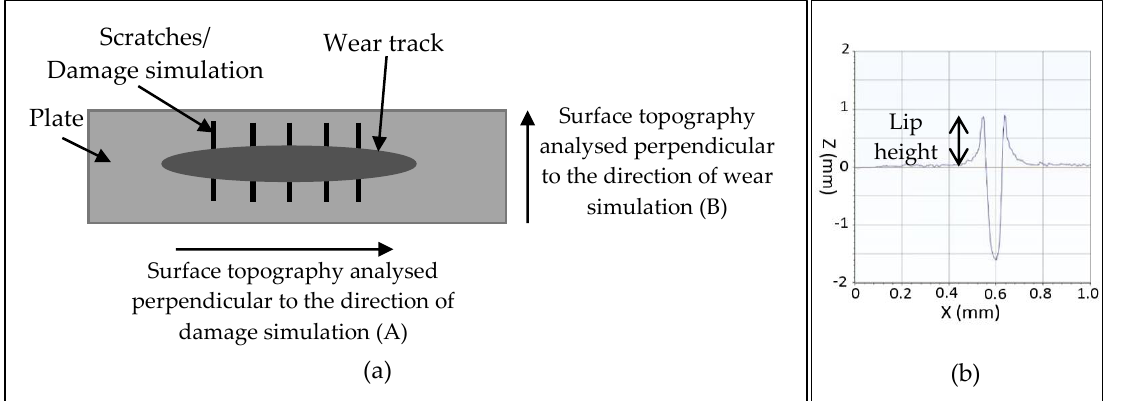
Figure 1. ( a ) Schematic showing the respective directions of the damage simulation and wear simulation; ( b ) schematic showing the profile of a 1 µm scratch created with a diamond stylus and the lip height measurement taken.